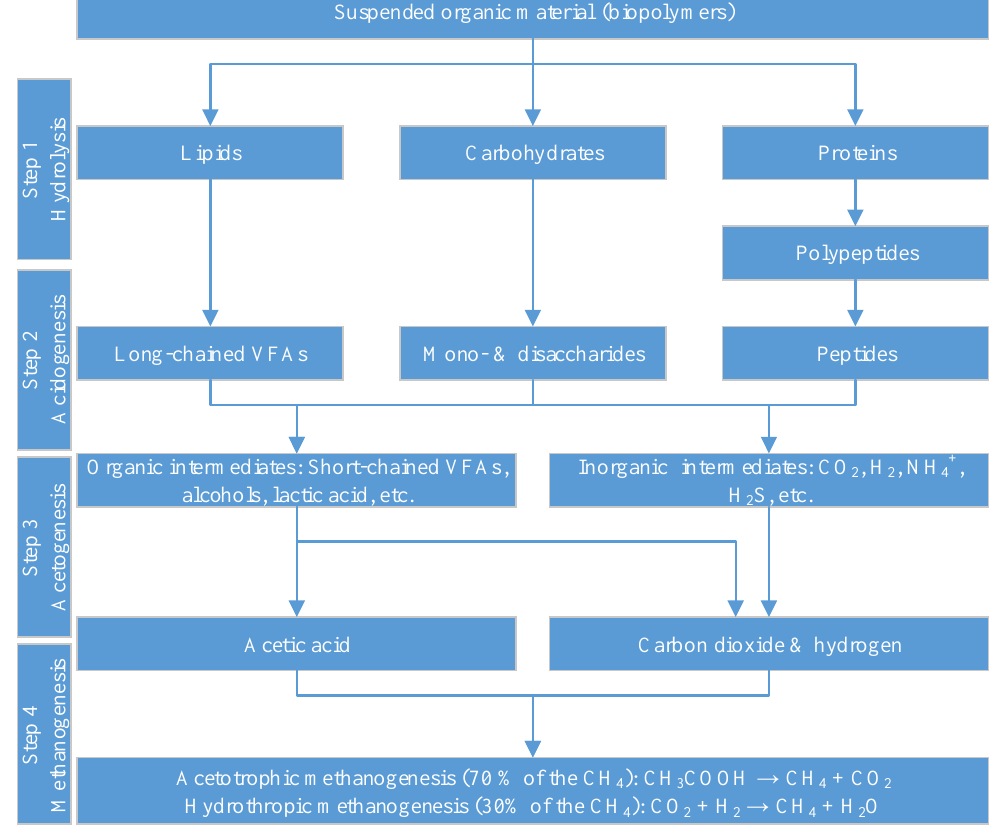
Figure 1. Breakdown of the AD process. Modified from Madsen et al. [17]. Reproduced with permission of Renewable and Sustainable Energy Reviews (Elsevier).